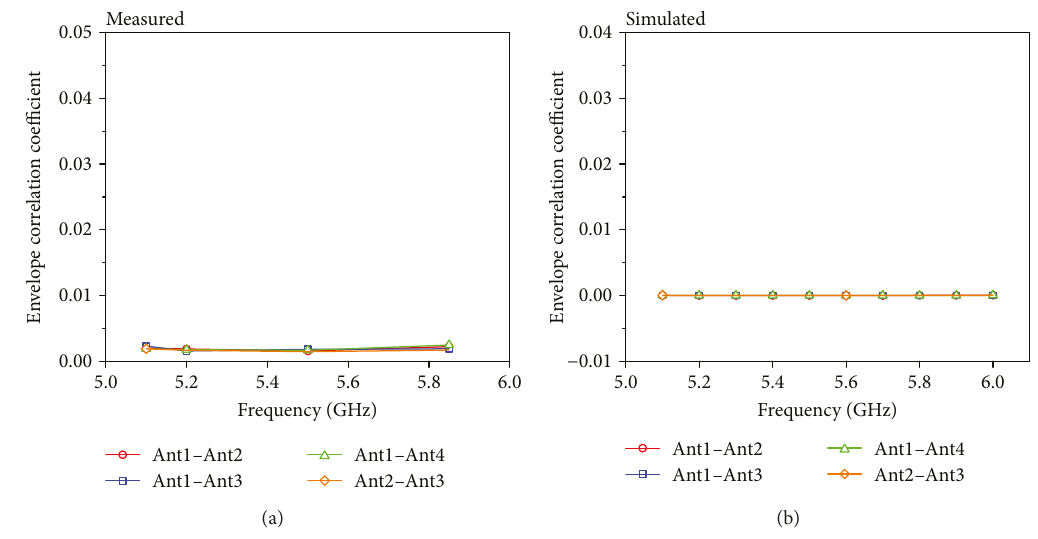
Figure 10: (a) Measured and (b) simulated ECCs of the four-element MIMO antenna.